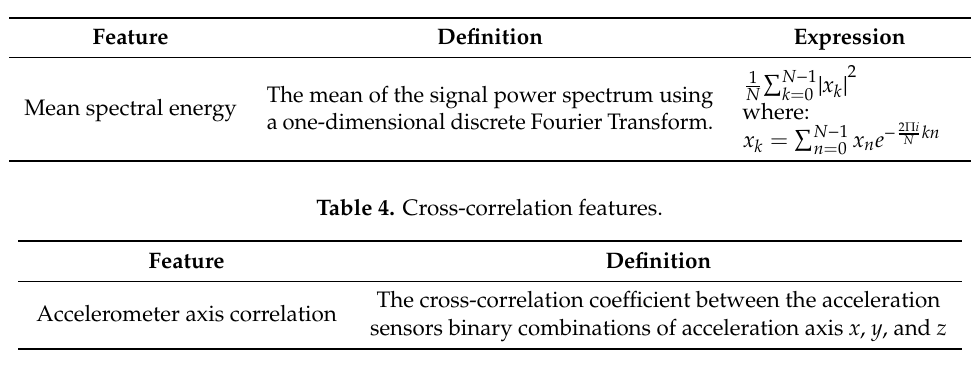
Table 3. Frequency-domain features.